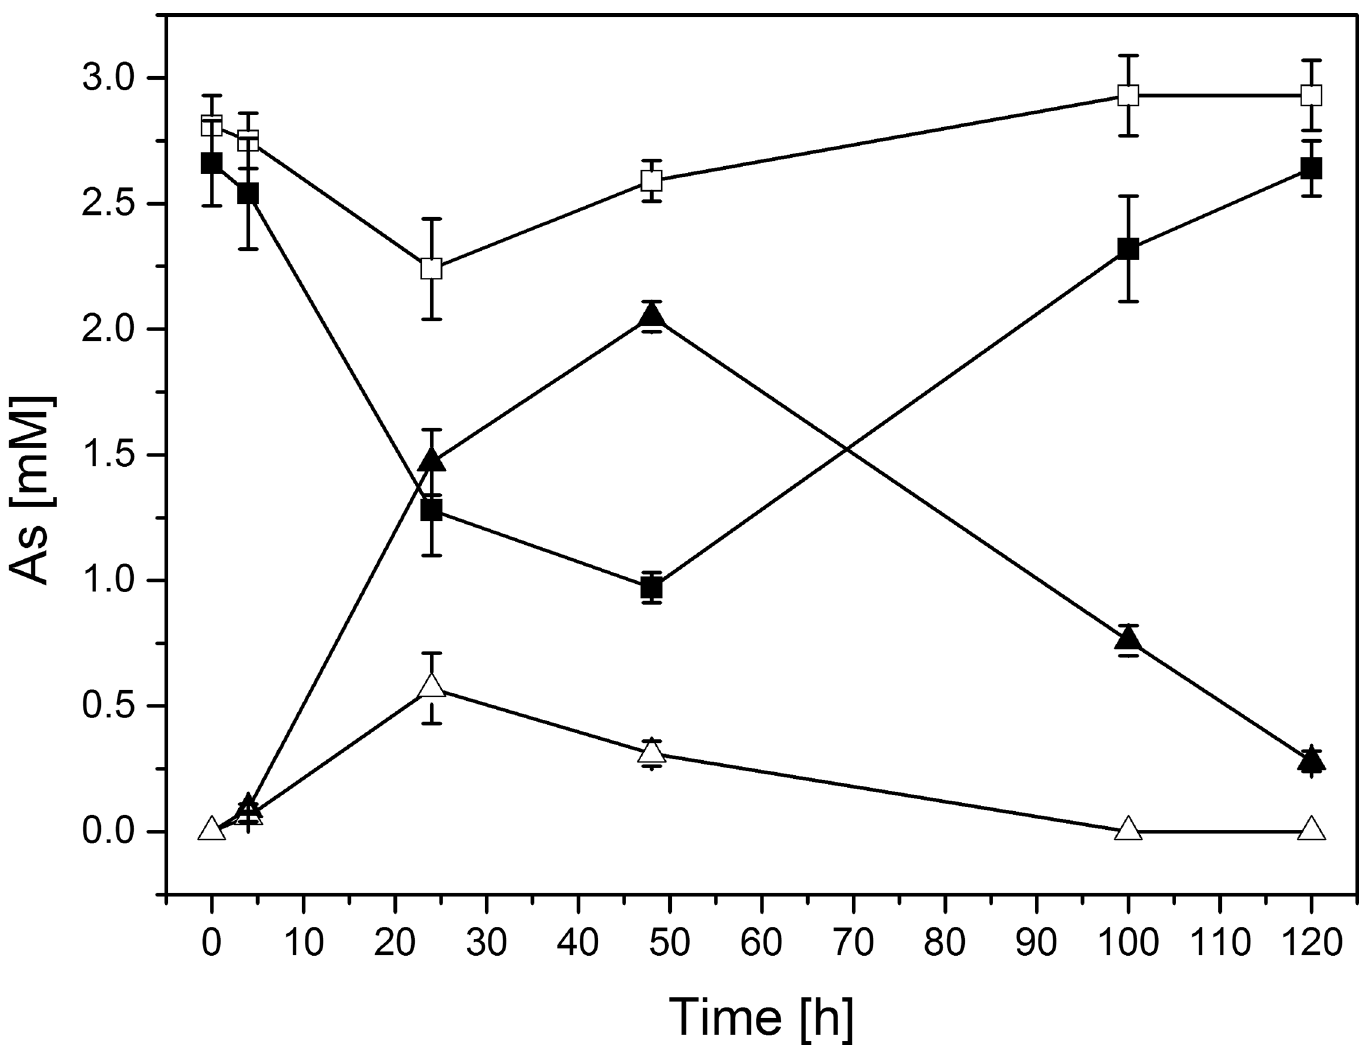
Fig 4. CB2 capacity to oxidize arsenite. Concentrations of As(III) (squares) and As(V) (triangles) are shown for CB2 cells grown in m126 medium in the presence of 2.66 mM of As(III) (full symbols) and m126 medium in the presence of 2.66 mM of As(III) and supplemented with glucose (hollow symbols). Error bars indicate standard deviations of triplicate cultures. No As(III) oxidation was observed in abiotic controls (data not